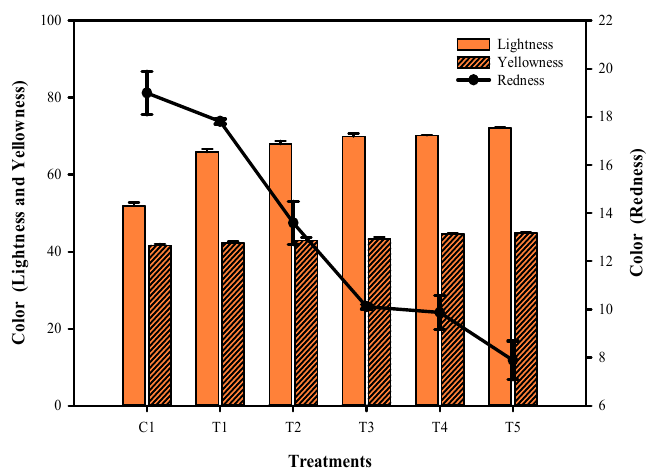
Figure 1. Color characteristics (lightness, yellowness, and redness) of the mung bean phyto-film that incorporated LPE and was processed under sonication.